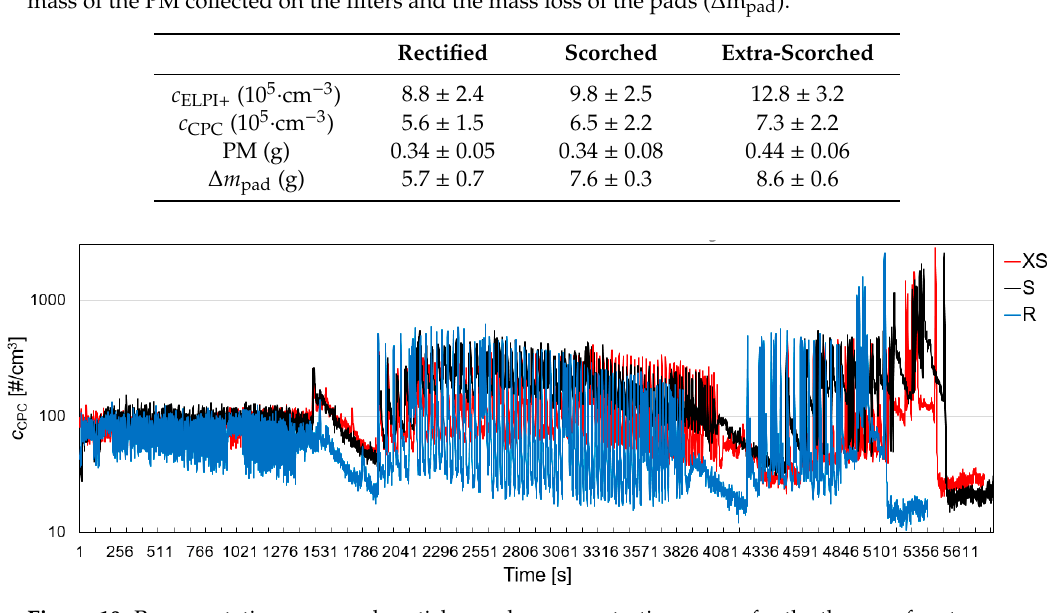
Figure 10. Representative measured particle number concentration curves for the three surface types as measured by the CPC instrument in the dyno bench setup. Rectified (R), scorched (S) and extra-scorched (XS).